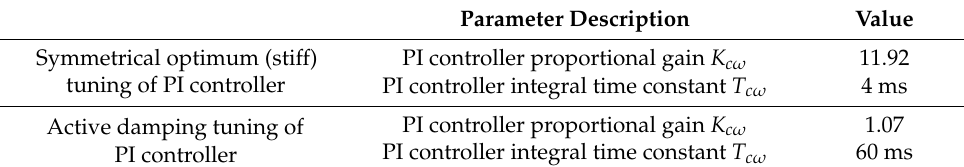
Table 2. BSG speed PI controller parameters for stiff and compliant transmission.